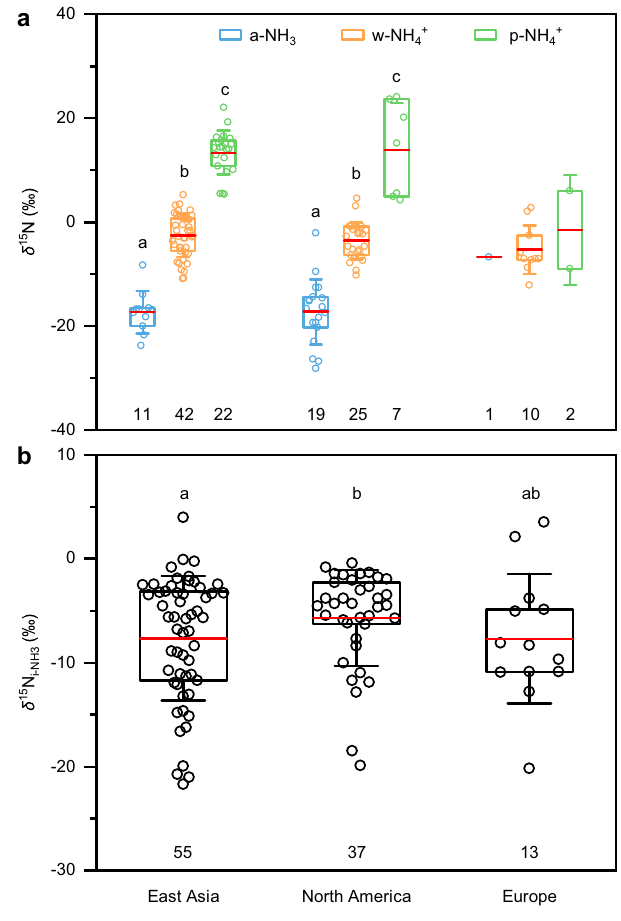
Fig.3| δ 15 NofambientNH 3 (a-NH 3 ),particulateNH 4 + (p-NH 4 + ),andprecipitation NH 4 + (w-NH 4 + ) (a) and the initial NH 3 mixture from different sources ( δ 15 N i-NH3 ) (b) in East Asia, North America, and Europe. Eachdata point represents the site- basedmean δ 15 N.Eachboxencompassesthe25 th − 75 th percentiles,whiskersandred lines in boxes are the SD and mean values, respectively. The number below each boxisthatofobservationsites.Notethatthesitewithsimultaneousa-NH 3 ,w-NH 4 + , or p-NH 4 + observation is counted as one site in sub- fi gure b. In sub- fi gure a, dif- ferent letters ( a, b, and c ) above the boxes indicate the signi fi cant differences ( p <0.05)amongspeciesinthesameregion;insub- fi gureb,differentletters( a and b ) above the boxes indicate the signi fi cant differences among the three